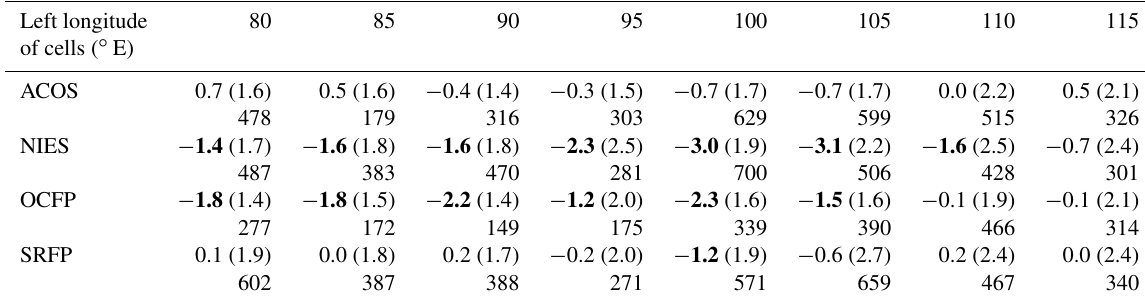
Figure 5. Correlation diagrams of GOSAT XCO 2 ( Y ) for the four algorithms vs. GEOS-XCO 2 ( X ). Statistics from a linear regression fit are also shown. GEOS-Chem data are selected according to the locations and time of XCO 2 retrievals from the four algorithms. Deep blue solid lines represent 1 : 1 lines, and the magenta lines demonstrate the best linear regression fit for all samples. Colored points represent XCO 2 for different longitude cells in the study latitude band [37, 42 ◦ N] shown in Fig. 1, where colors for each cell are indicated in the legend (right). Table 3. The biases (ppm) and their SDs (ppm) of the four algorithms vs. GEOS-Chem in each cell, where the upper line indicates bias (the corresponding SDs in parenthesis) for each algorithm vs. GEOS-Chem and the lower line is the available number of used samples. The biases, larger than 1ppm, are highlighted in